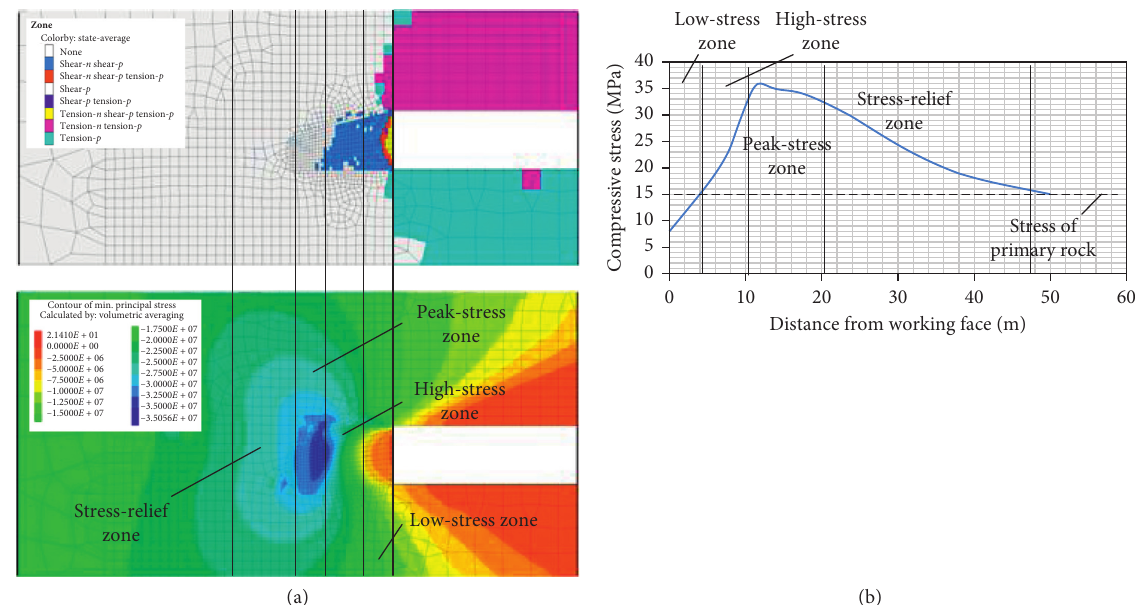
Figure 5: Distribution of the advanced abutment pressure at the working face during stoping. (a) Vertical view and (b) stress distribution curve.